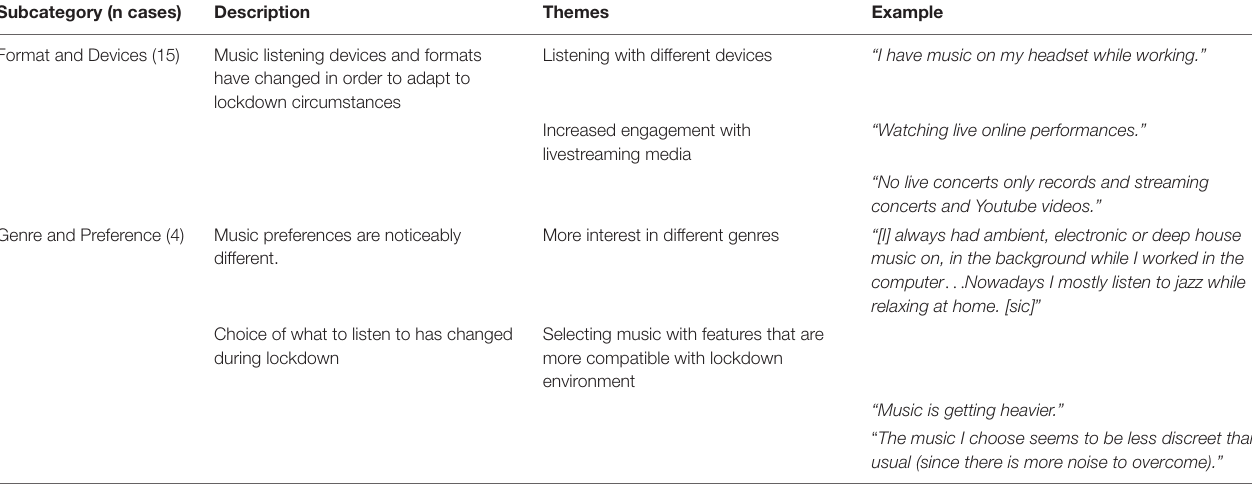
TABLE 5 | Subcategories related to Change in Engagement.